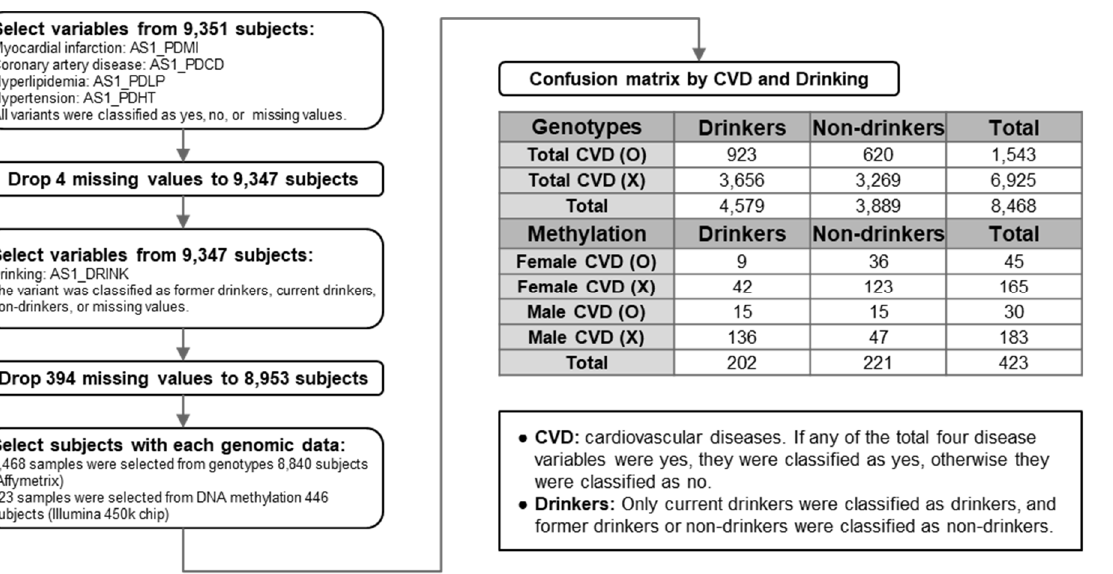
Figure 1. Flowchart for selection of the study population. The study population included 8840 genotypes and 446 methylation analysis results among 9351 subjects. Chronic cardiovascular diseases (CVDs) were considered as present when there was at least one of the following four chronic diseases: myocardial infarction, coronary artery, hyperlipidemia, and hypertension. “AS1_PDMI”, “AS1_PDCD”, “AS1_PDLP”, “AS1_PDHT”, and “AS1_DRINK” indicate the variable codes of my- ocardial infarction, coronary artery, hyperlipidemia, hypertension, and drinking status, respectively. Analysis was performed on 8468 subjects for genotyping and 423 subjects for methylation, which correspond to the intersection of the four aforementioned CVD-affected and drinking sample